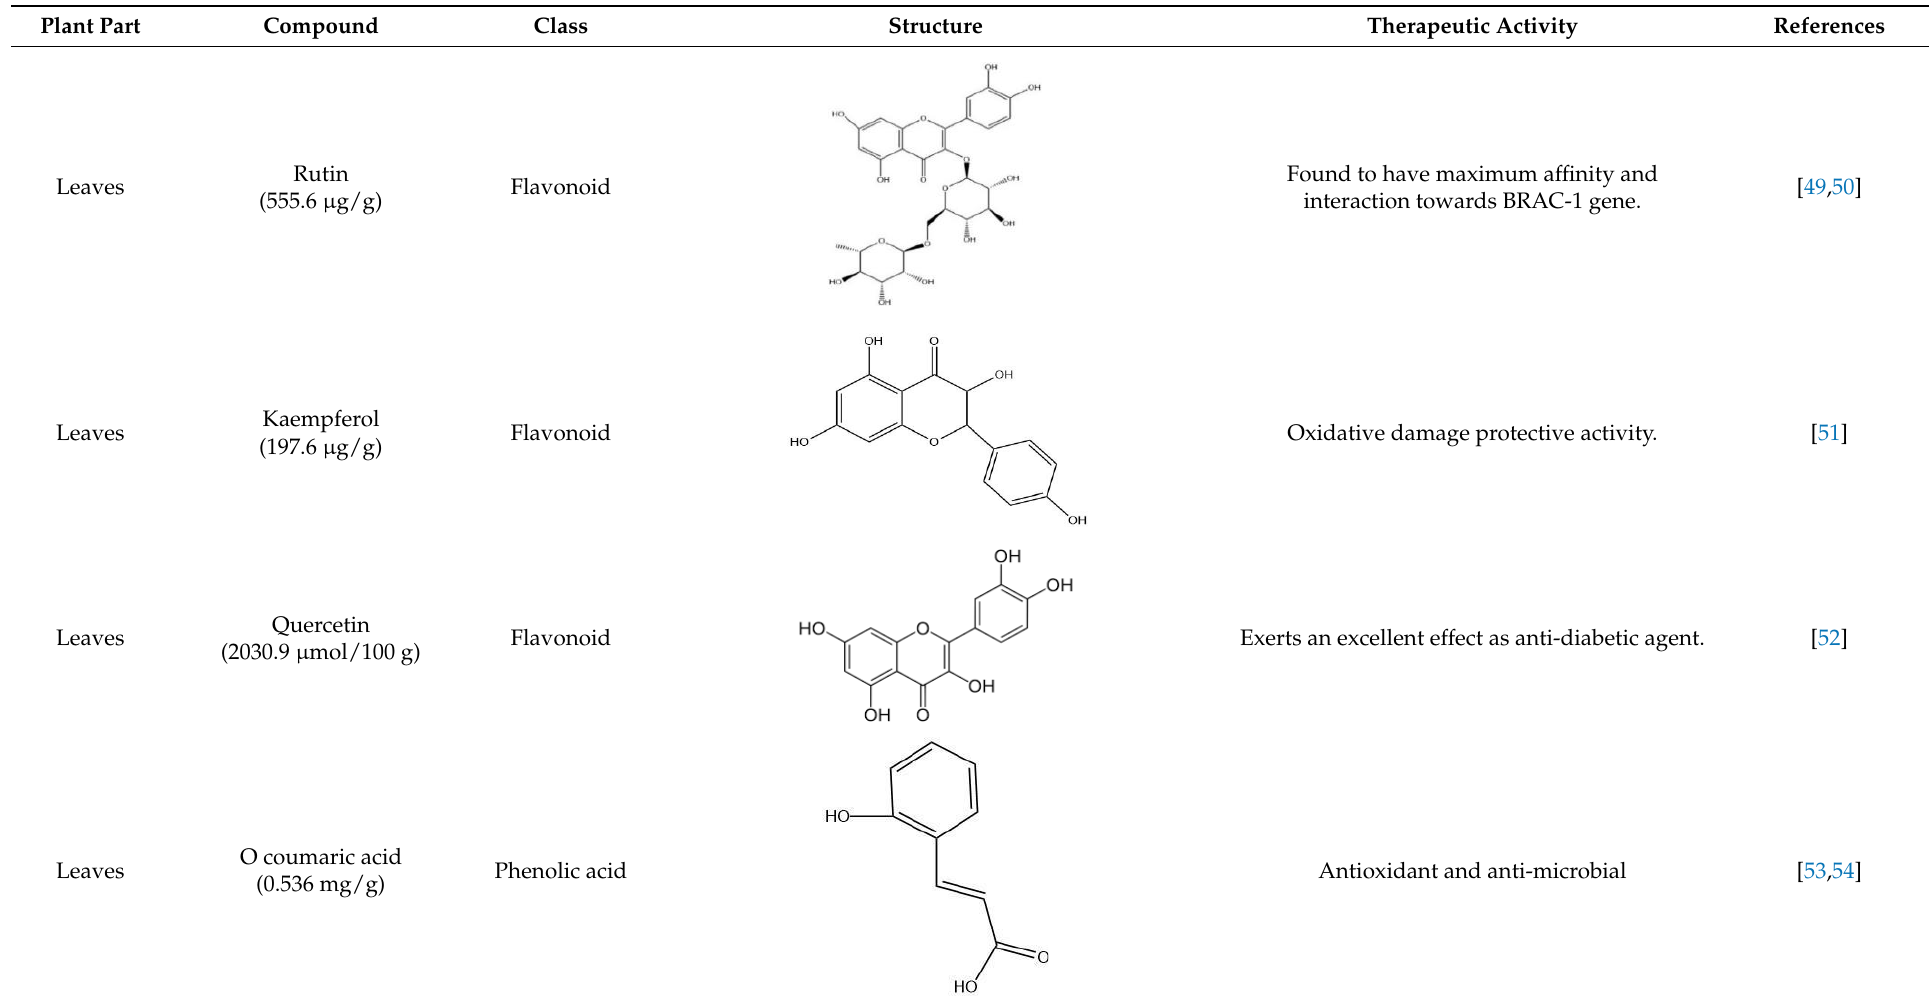
Table 2. Phytoconstituents of Moringa and their relevant therapeutic effects.